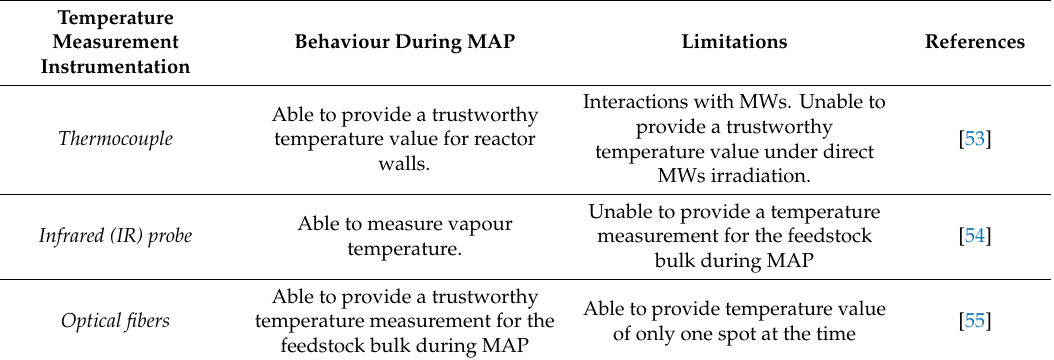
Table 1. Summary of common temperature measurement instruments used during pyrolysis with their limitation for microwave assisted pyrolysis (MAP)